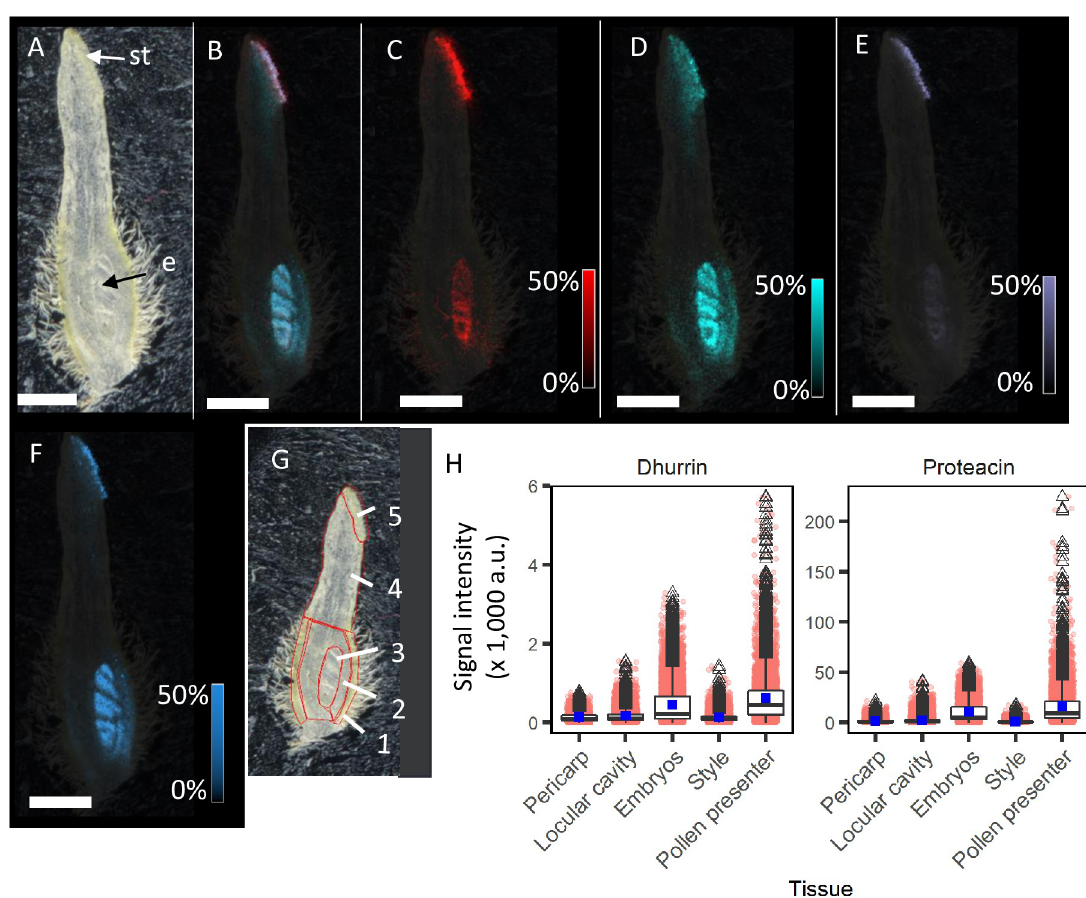
Fig 6. MALDI-MS images of longitudinal section of Neorites kevedianus fertilised floret. (A) Optical image of young fruit longitudinal-section (35 μ m thick), where st is stigmatic surface, e–embryos. (B) Merged positive ion MALDI-MS image showing dhurrin and proteacin, (C) dhurrin [M + Na] + ( m/z 334.0896, Δ m 0.3 mDa), (D) dhurrin [M + K] + ( m/z 350.0635, Δ m 0.6 mDa), (E) proteacin [M + Na] + ( m/z 496.1421 Δ m 0.8 mDa) and (F) proteacin [M + K] + ( m/z 512.1164, Δ m 0.2 mDa). All MALDI-MS images were obtained using 30 × 30 μ m array. White scale bars indicate 1 mm. Coloured intensity scales represent 0–50% TIC normalised signal intensity. (G) Regions of Interest (ROIs) selected for cyanogenic glycoside signal intensities comparison analysis–(1) pericarp, (2) locular cavity, (3) embryos, (4) style, (5) pollen presenter. (H) Signal intensities of dhurrin ([M + K] + ( m/z 350.0635), and [M + Na] + ( m/z 334.0896) combined), and proteacin ([M + K] + ( m/z 512.1164) and [M + Na] + ( m/z 496.1421) combined) for respective ROIs, the box plot represents the entire signal intensity delimited by the 25 th and 75 th percentiles, with error bars denoting the 10 th and 90 th percentiles. Values outside those ranges are represented by open triangles, the mean (dark blue square) and median (solid line). Pink dots represent signal intensity in individual pixel. Dhurrin to proteacin ratios in tissues are provided in S4